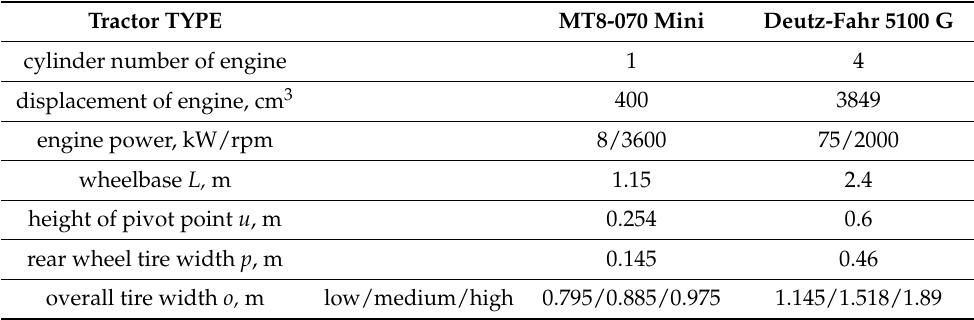
Table 1. Specifications of the experimental